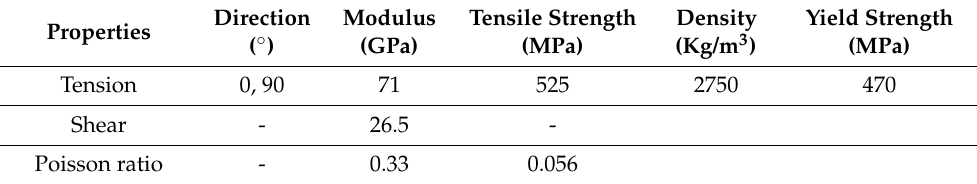
Table 3. Aluminum alloy 7050 (room temperature